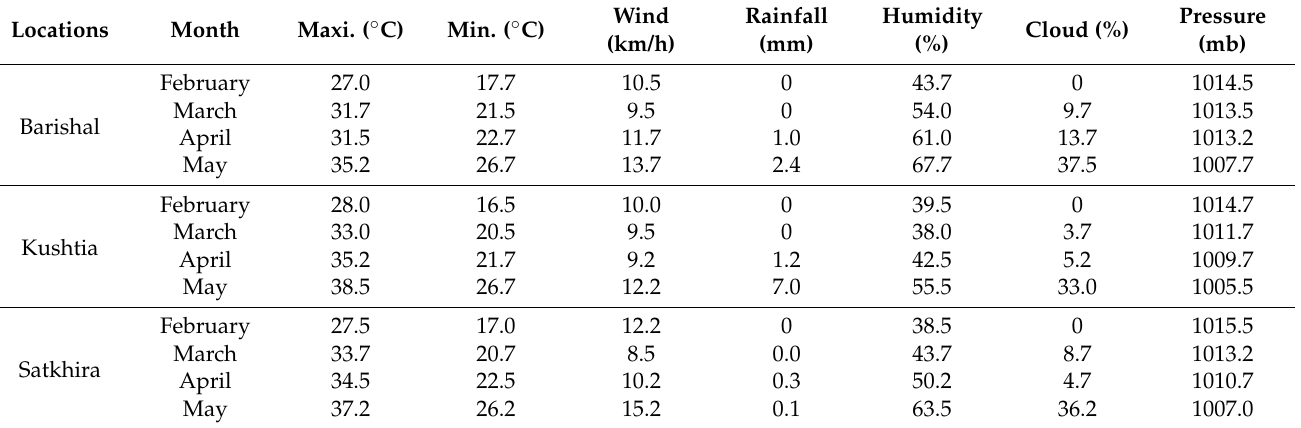
Table 1. Monthly mean agro-climatic data during the field experiment period in Barishal, Kushtia, and Satkhira.